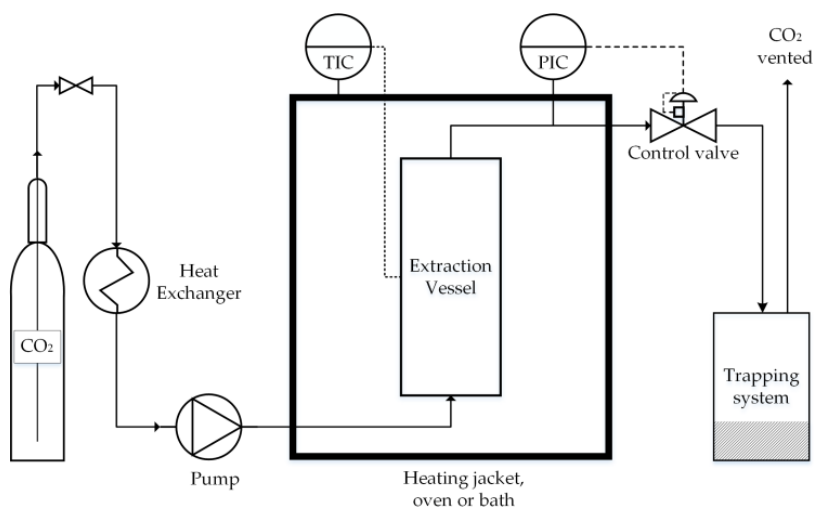
Figure 5. Generalized semi-continuous sCO 2 extraction system.